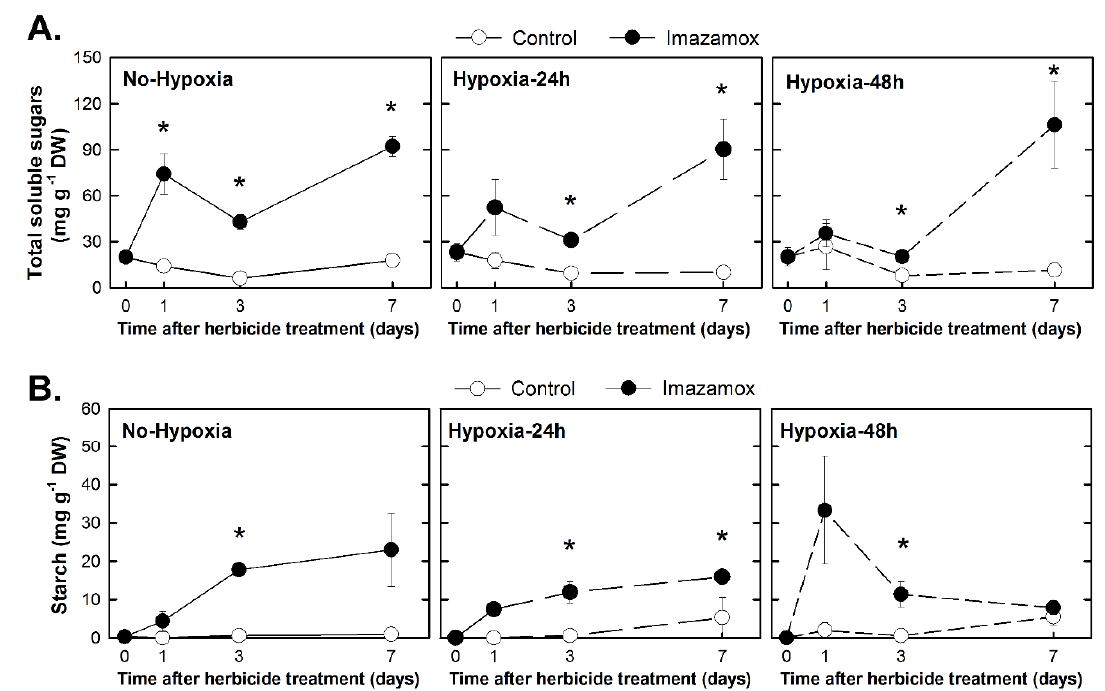
Figure 4. Total soluble sugars ( A ) and starch ( B ) content in the root of pea plants. Pea plants were not treated with hypoxia before herbicide application (the No-Hypoxia group) or were treated with hypoxia for 24 h or 48 h before herbicide application (the Hypoxia-24h and Hypoxia-48h groups). Half of the plants from each group were treated with imazamox (5 mg L −1 , black symbols). In each group, the others were not treated with herbicide and were used as the controls (white symbols) for the imazamox-treated plants. Values represent the mean ± SE ( n = 4 biological replicates). Significant variations are marked with * for differences between control and imazamox-treated plants ( t -Test, p < 0.05) on a given day. See Supporting Information Table S1 for the two-way ANOVA results .